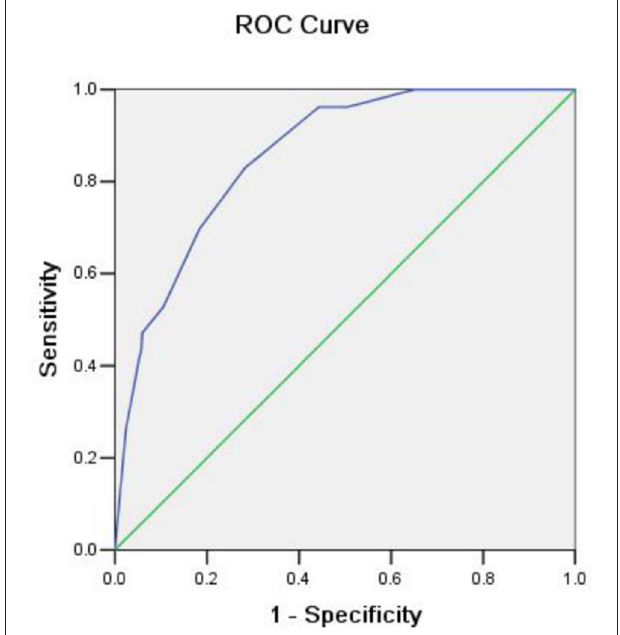
FIGURE 4 | Receiver operating characteristic (ROC) curve showing the predictive ability for guidewire insertion